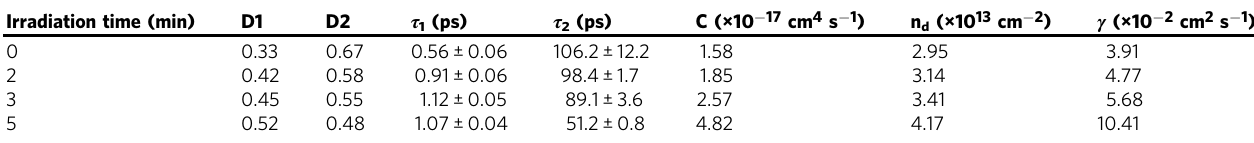
Fig. 1 Mode-locked laser based on pristine Bi 2 O 2 Se nanoplates. a Average output power of the CWML versus absorbed pump power. As the pump power increases, the mode-locked operating state transitions from continuous wave (CW) to Q-switched mode-locking (QML), and fi nally switches to CWML state. b Autocorrelation trace for ~587 fs duration. c Recorded frequency spectrum with narrow and wide (inset) spans. d Normalized differential transmission of Bi 2 O 2 Se nanoplates with different plasma treatment times at T = 300 K and F = 71.9 µ J/cm 2 . e Blue dots are the time evolution of the carrier density. The red (orange) line indicates the simulated temporal evolution of the free (trapped) carrier density using Eq. (1)(2). Inset: Schematic illustration of carrier trapping by defects and the subsequent defect-assisted Auger recombination. Table 1 The fi tting parameters extracted from Eqs. (1) and (2) to model pump-probe traces of Bi 2 O 2 Se nanoplates under different plasma irradiation